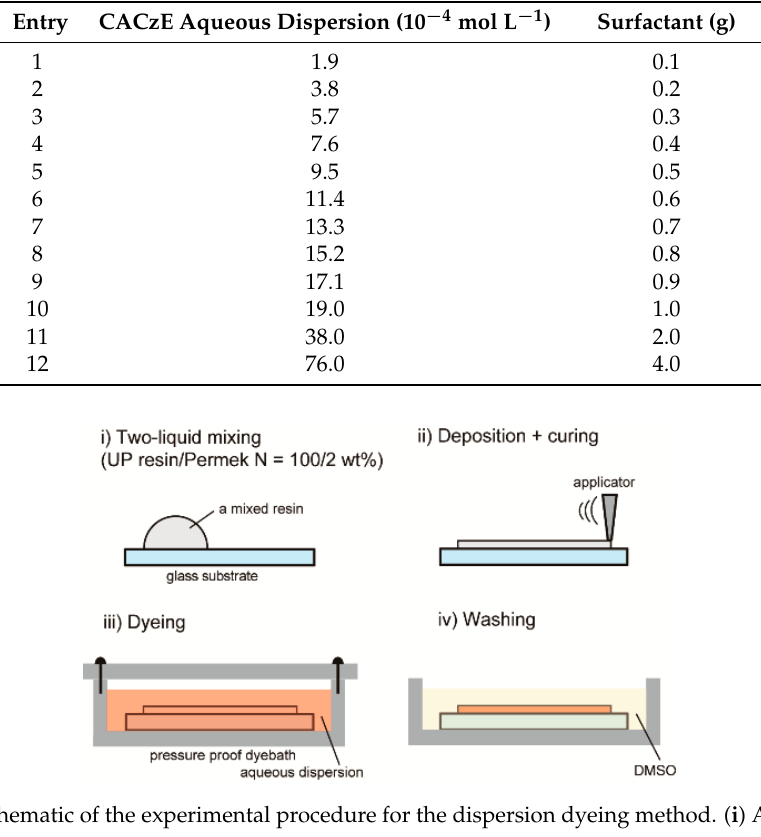
Figure 2. Schematic of the experimental procedure for the dispersion dyeing method. ( i ) A two-liquid mixing resin (UP resin/Permek N = 100/2 wt.%) deposited on a glass substrate; ( ii ) coating with an applicator with a 100 µ m gap and curing; ( iii ) dyeing in the pressure proof dyebath; and ( iv ) washing with DMSO. Table 1. Experimental conditions for the aqueous dispersions.